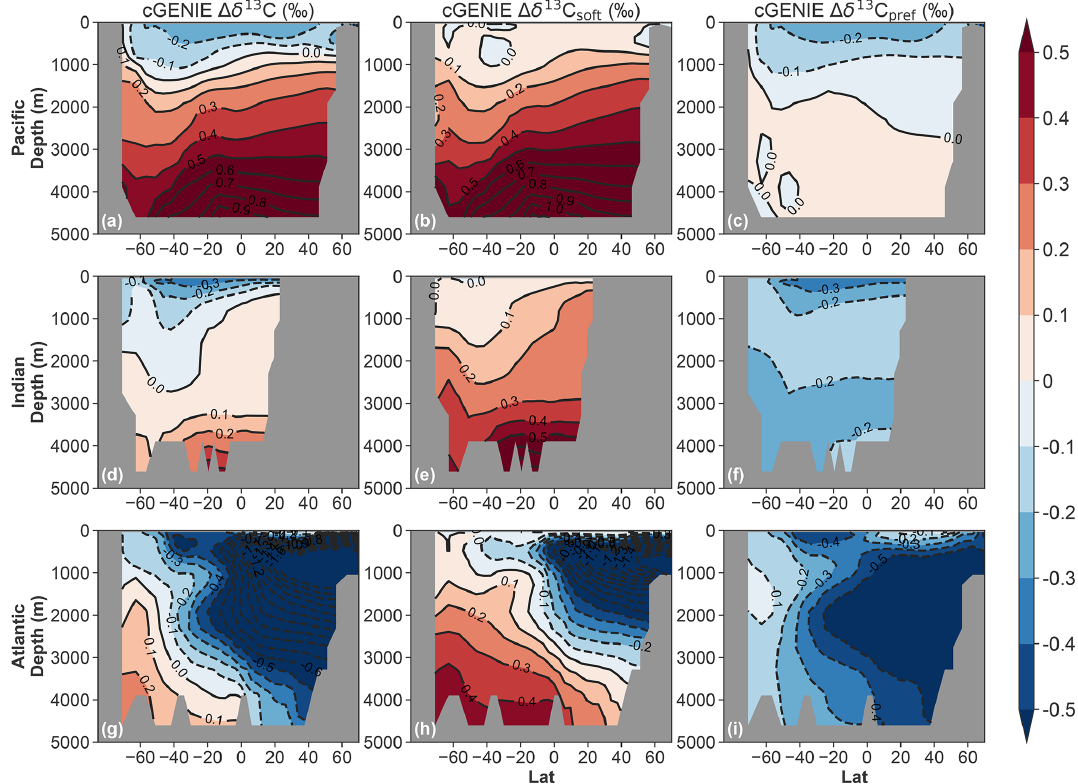
Figure 4. Ocean basin zonal mean anomalies (15ka minus 17.2ka), but for the cGENIE deglacial transient simulation. Panels are organized as in Fig.